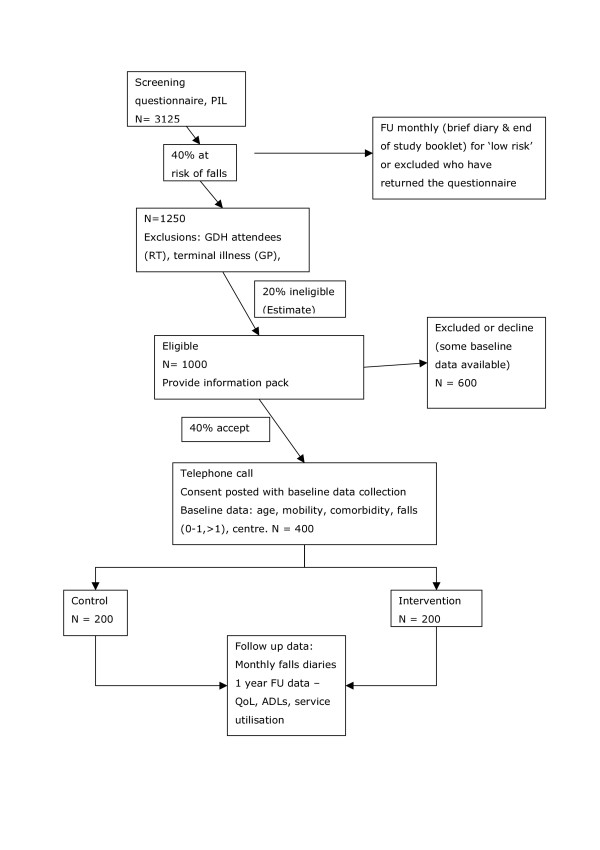
Participant flow.